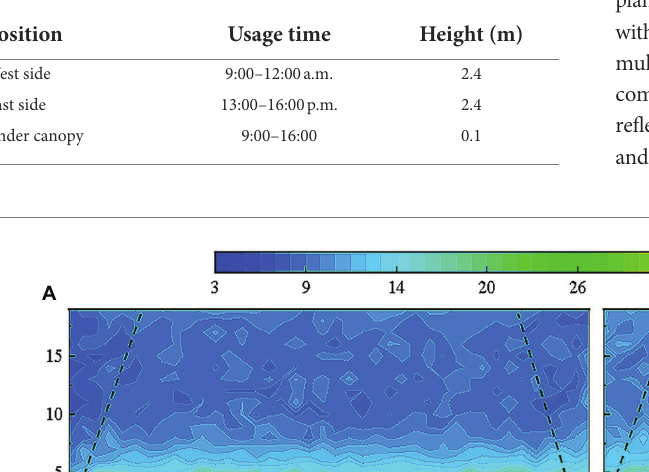
TABLE 3 Final reflective film configuration scheme.